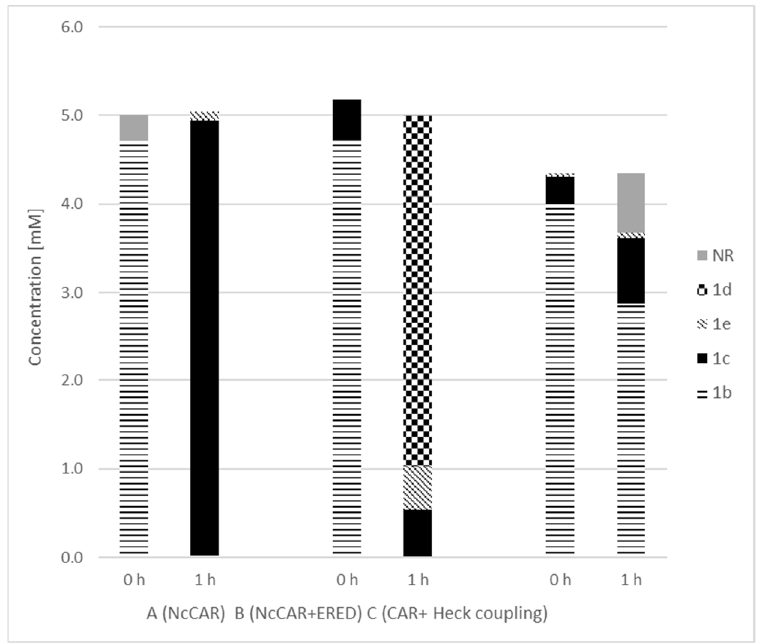
Figure 2. Whole cell biotransformation of 5 mM 1b or Heck coupling resulting 1b to 1c or 1d . A: E.